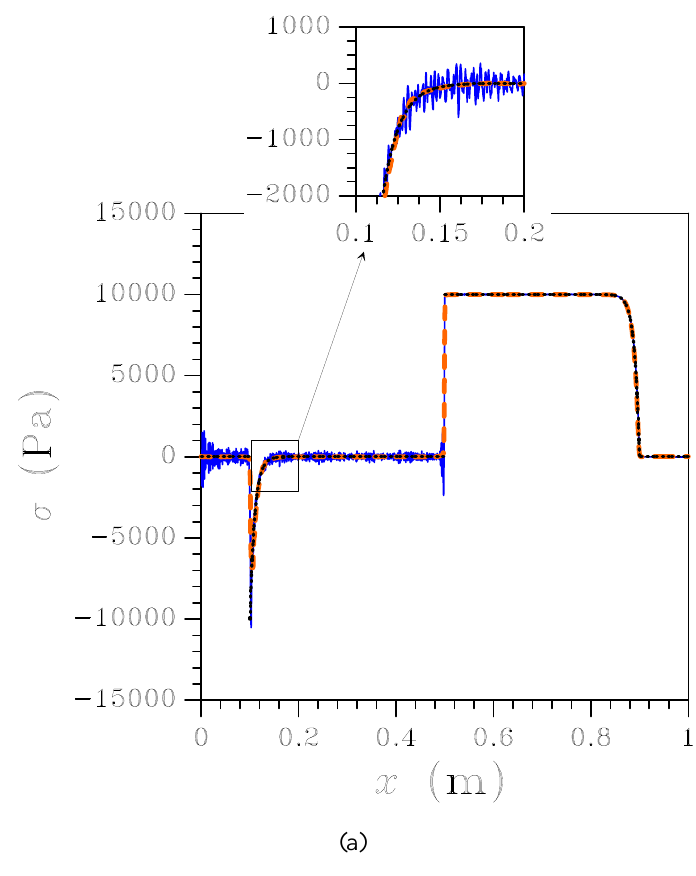
Figure 11. Wave propagating along an interface-containing homogeneous rod ( E N/m 3 ) discretized with an unstructured mesh: stress field at t = 0 . 9 · 10 − 2 s. Black dotted line: analytical solution; blue solid line: FE solution; orange dashed line: newly proposed FE-FCT